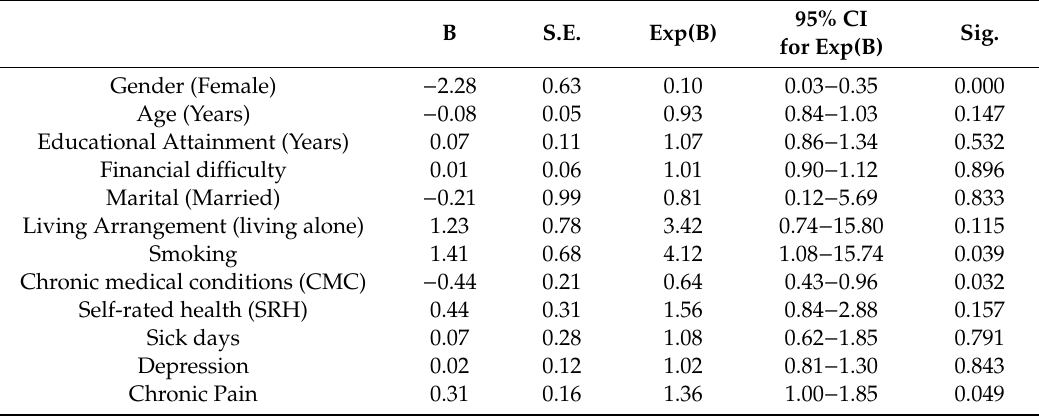
Table 4. Multivariable logistic regression model with binge drinking as the outcome.